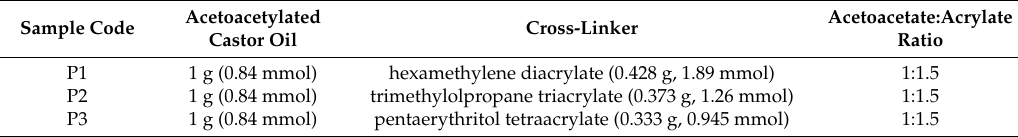
Table 1. Film codes and the ratio of materials of the Michael addition reaction.